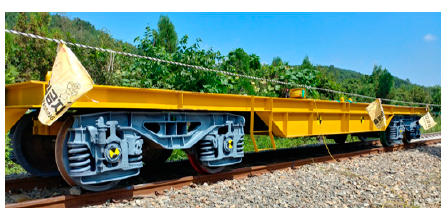
Figure 18. View of the test wagon. Figure 17. Different models of the wagon frame. F igure 18. View of the test wagon.